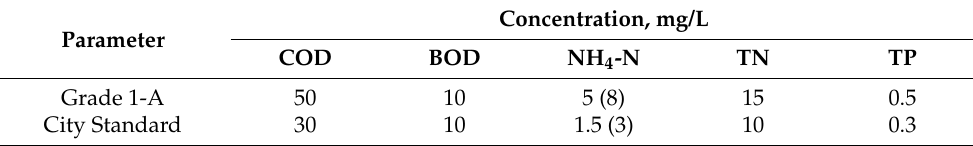
Table 1. Wastewater discharge requirements of the national norm Grade I A and the City Standard